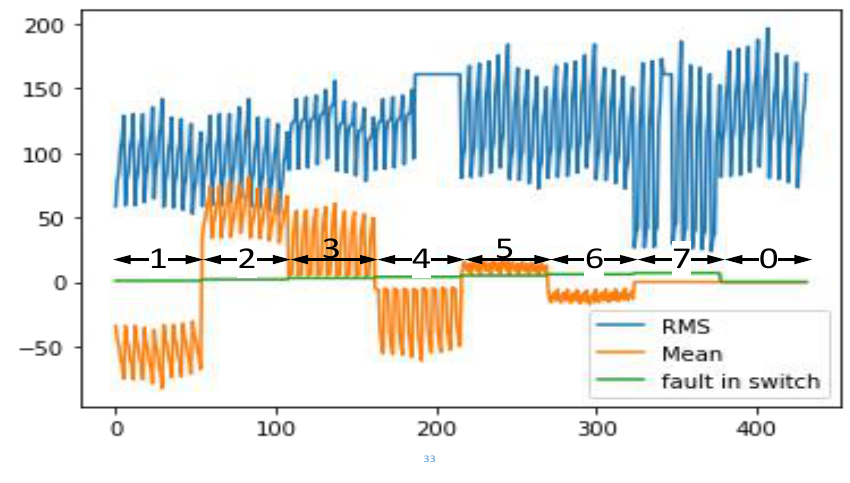
Figure 10. Dataset plot. Table 5. Sample dataset features.